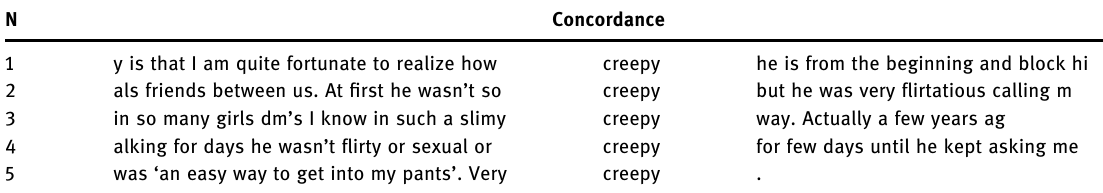
Table 18: Concordance lines for